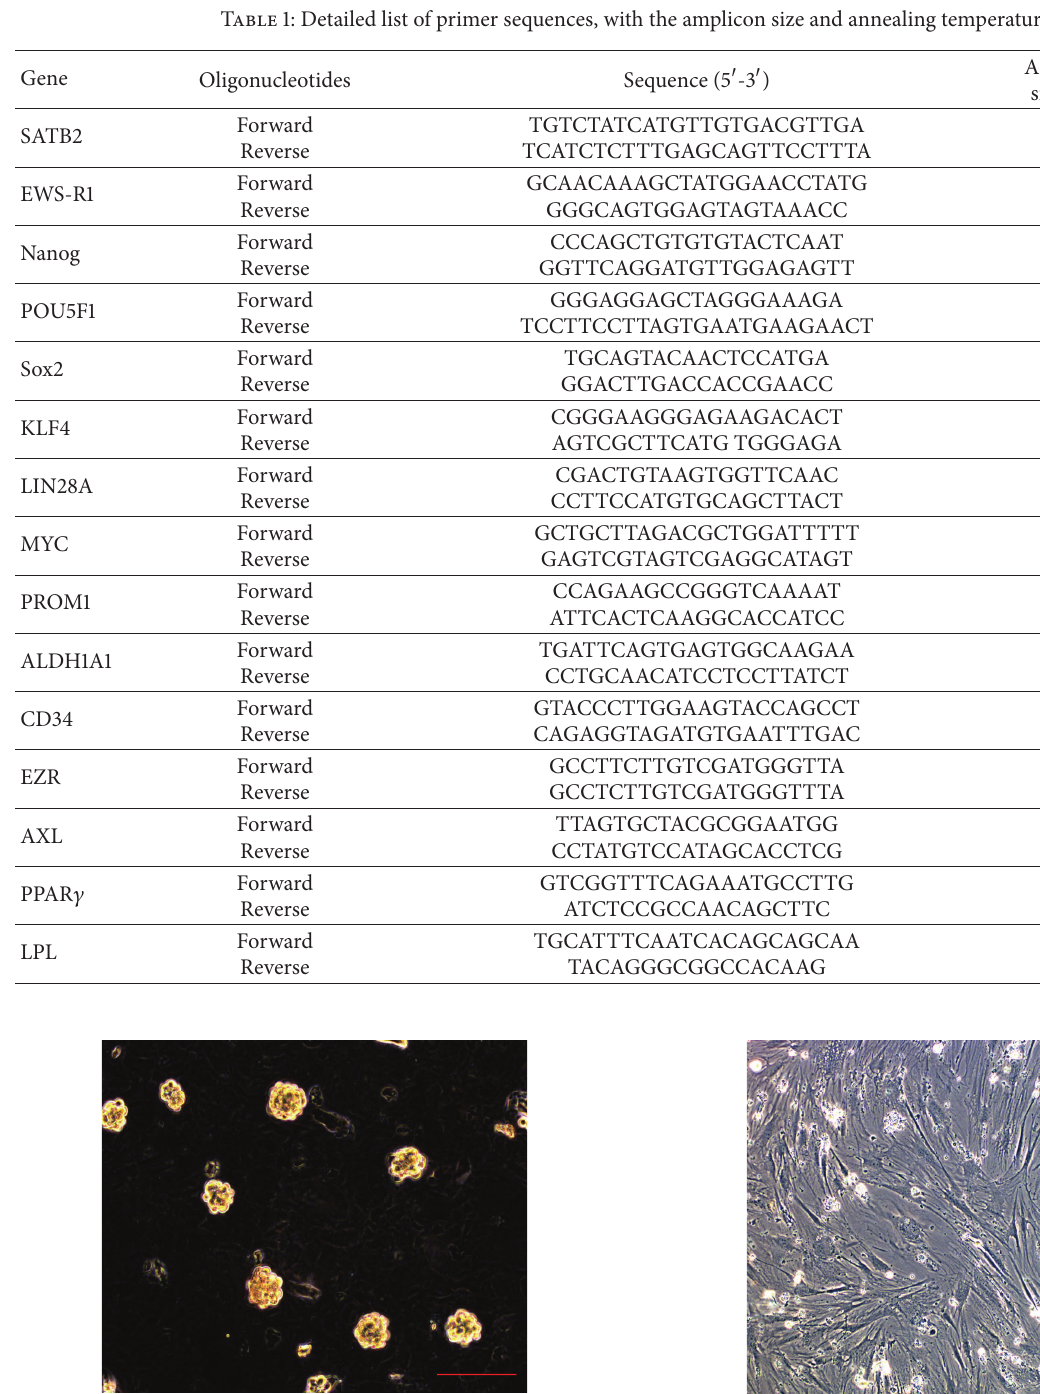
Figure 15: Cancer stem cell line OSA3-CSCs II. Observation in phase contrast. Original magnification: 10x. Bar size: 100 𝜇